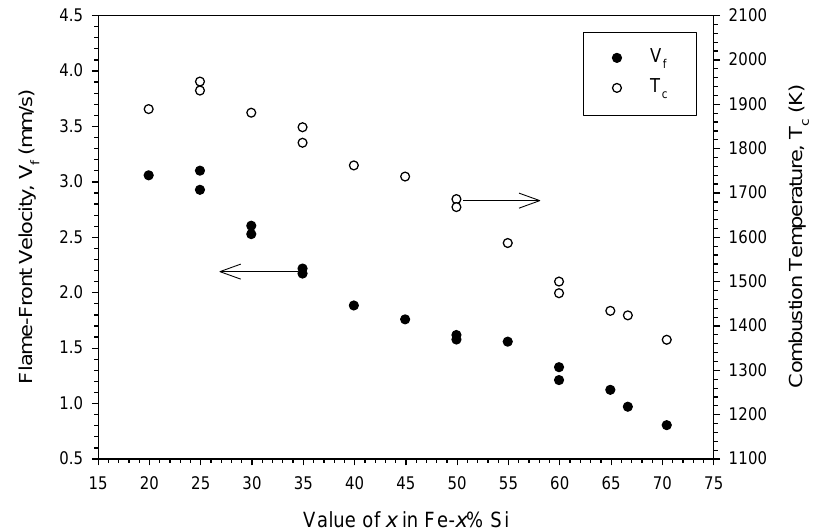
Figure 2. Variations of flame-front velocity ( V f ) and combustion temperature ( T c ) with Si percentage of Fe- x % Si of sample compacts. According to combustion wave kinetics, the activation energies ( E a ) of Reactions (1) and (2) were determined on the basis of the correlation between ln( V f / T c ) 2 and 1/ T c . Two sets of experimental data with their best-fitted linear lines are plotted in Figure 3. From the slopes of straight lines, the values of E a equal to 171.3 and 106.4 kJ/mol were deduced for Reactions (1) and (2), respectively. The activation energy represents a kinetic barrier that depends on the reaction mechanism and transport phenomena. The possible reaction pathways of Reactions (1) and (2) were initiated by the aluminothermic reduction of Fe 2 O 3 . In addition to the kinetic aspect, the reduction of Fe 2 O 3 by Al was thermodynamically favorable and acted as the major heat-releasing step to sustain the SHS process. Differ- ent silicide phases formed from SHS reactions could be responsible for a larger E a for Reaction (1) than Reaction